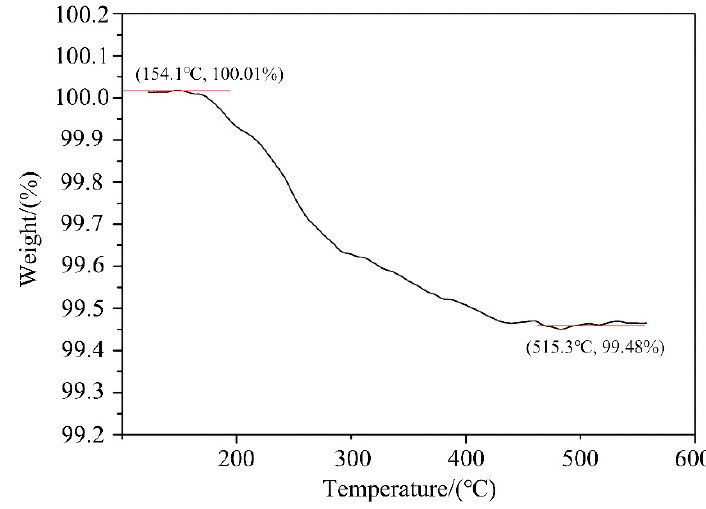
Figure 6. Thermogravimetric analysis of Al–20Si@Al 2 O 3 .